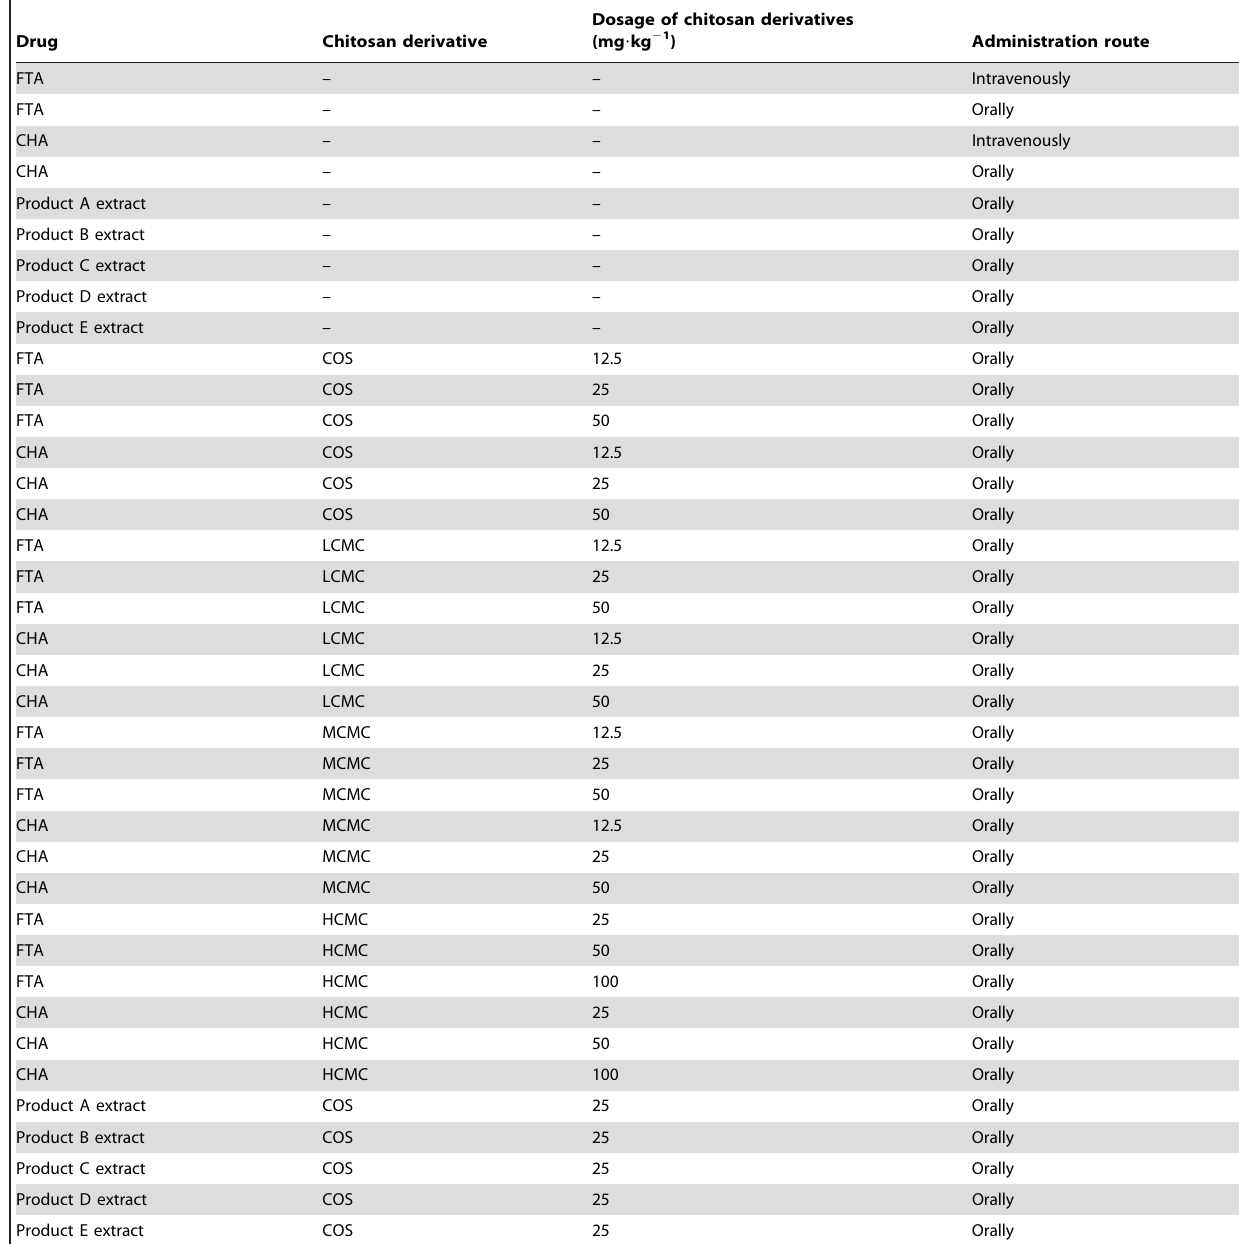
Table 3. The dosage regimen of FTA and CHA in rat.